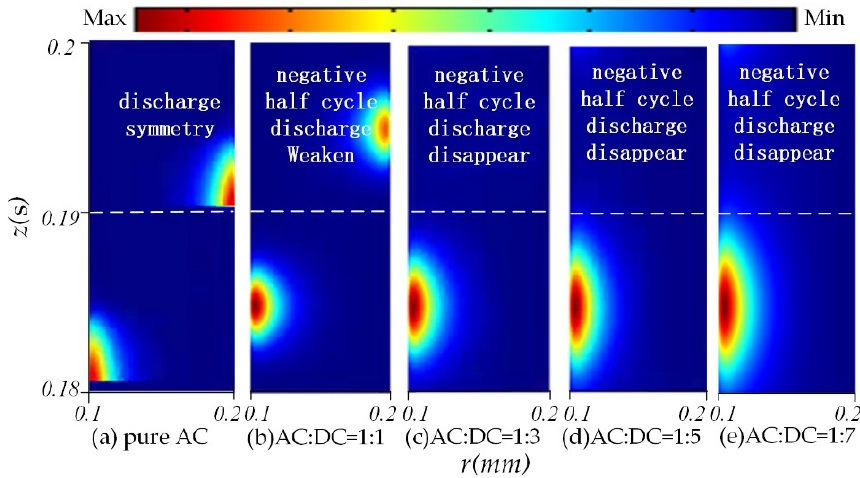
Figure 3. Normalized periodic electron density under different ratios of combined voltage. ( a ) pure AC, ( b ) AC:DC = 1:1; ( c ) AC:DC = 1:3; ( d ) AC:DC = 1:5; ( e )AC:DC = 1:7.